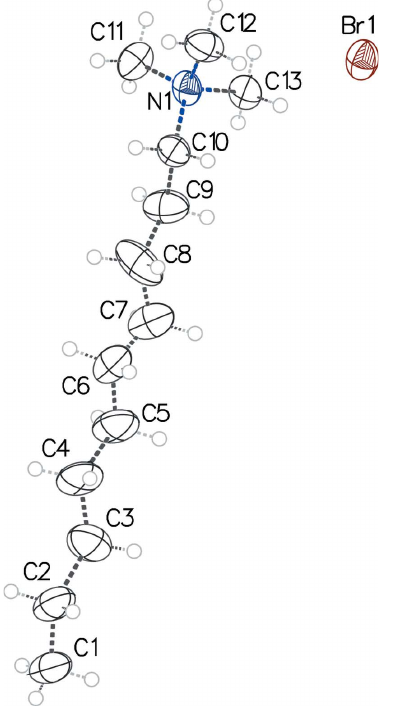
Figure 1 The asymmetric unit of the title salt, [C 13 H 30 N]Br, showing one conformation of the statistically disordered n -decyl chain. The displace- ment ellipsoids are drawn at the 50% probability